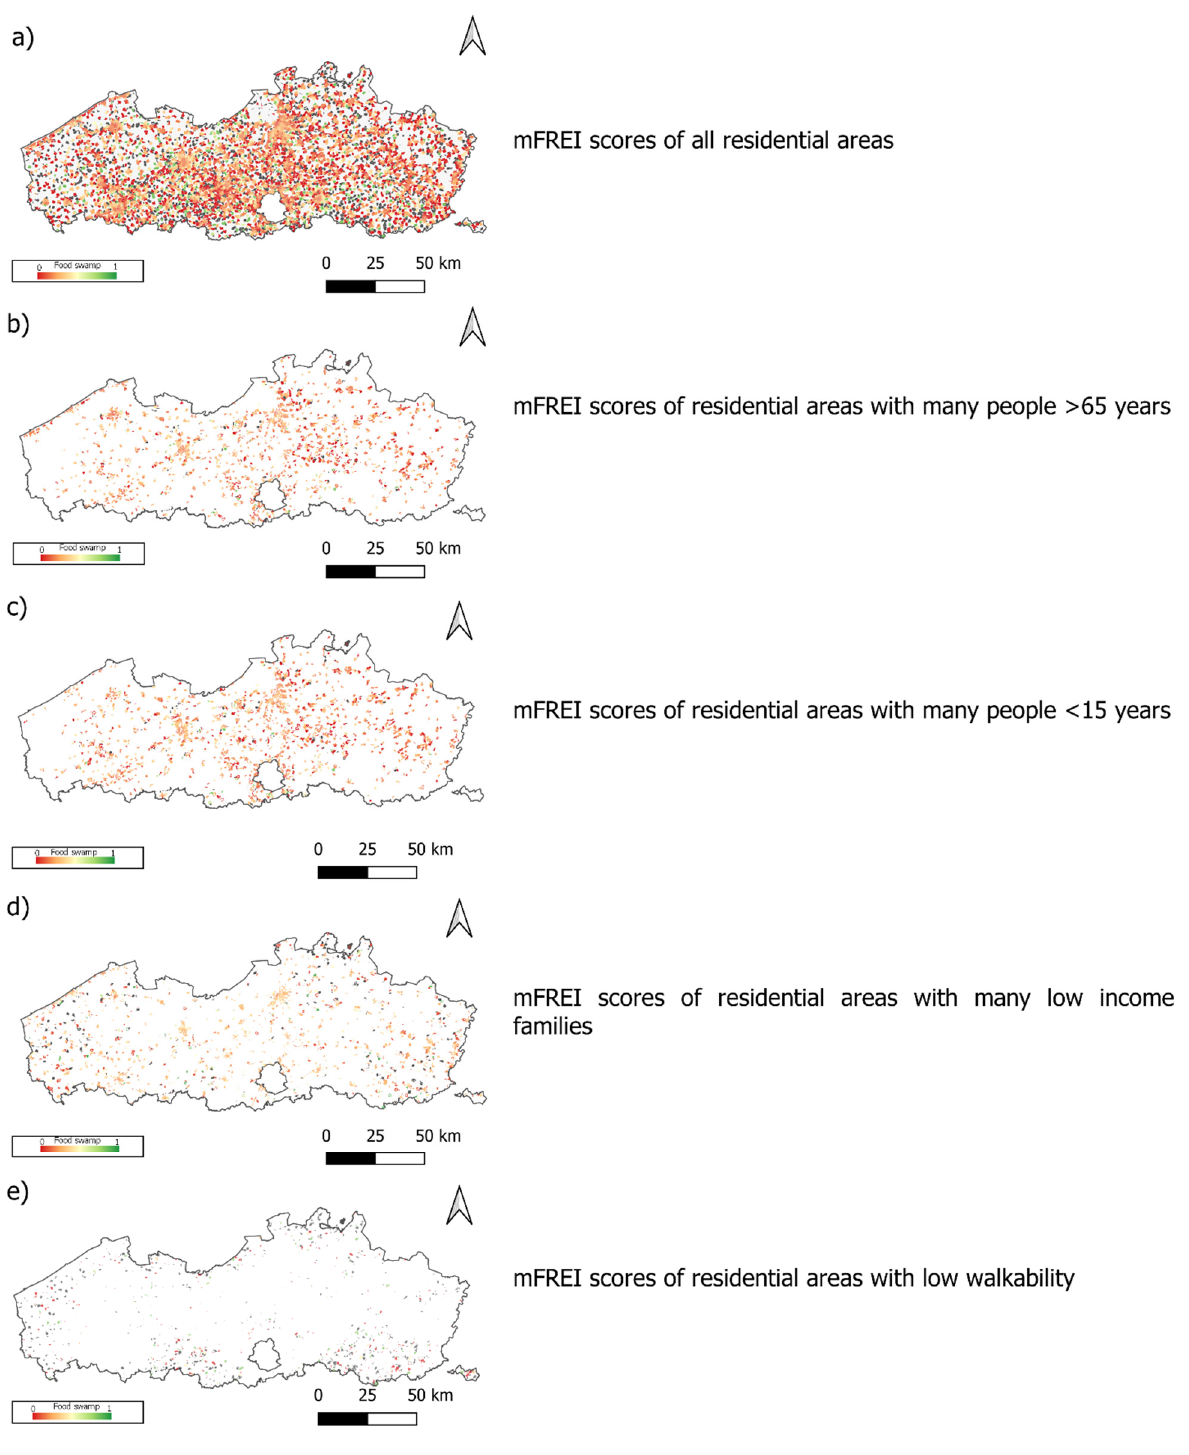
Figure 8 . ( a ) The geographical dispersion of food swamps (mFREI scores) in Flanders; ( b ) food swamps in areas with a high number of people > 65 years; ( c ) food swamps in areas with a high number of people < 15 years; ( d ) food swamps in areas with low incomes; ( e ) food swamps in areas with low walkability (data from 2020 and includes community gardens, farmers’ markets and farmers’ outlets). The scale goes from mFREI score ‘0 ′ or very unhealthy (dark red) to mFREI score ‘1 ′ or very healthy (dark green). The dark grey areas are residential areas without any food retailers.